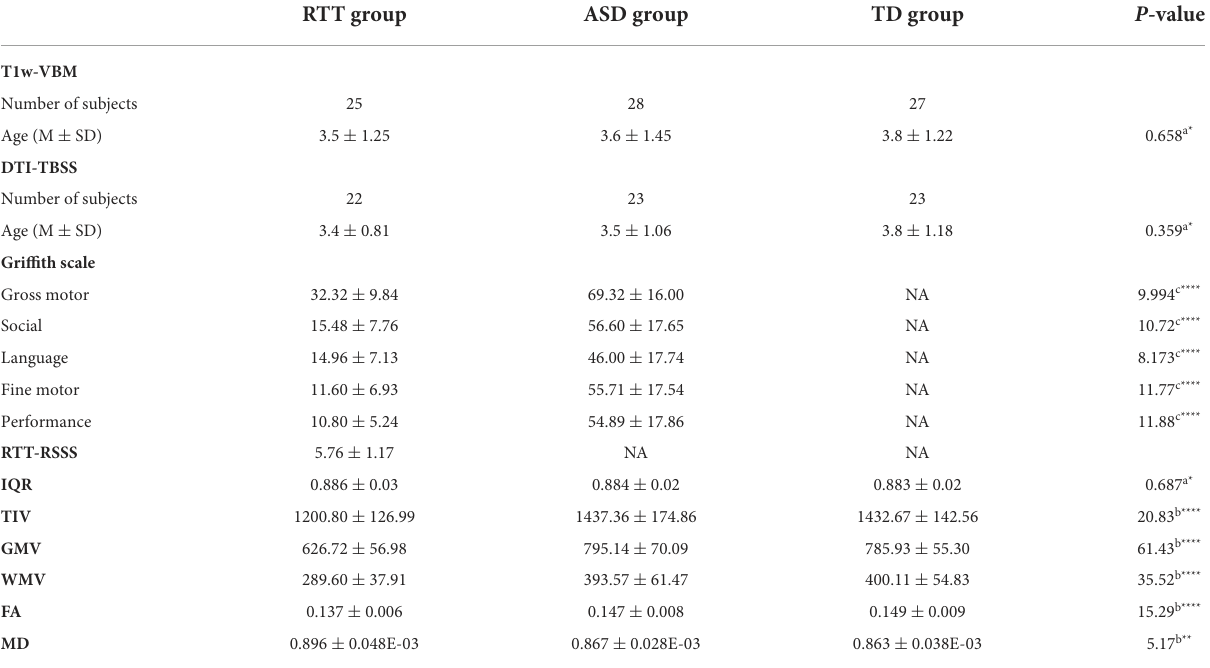
TABLE 1 Summary of clinical characteristics of study